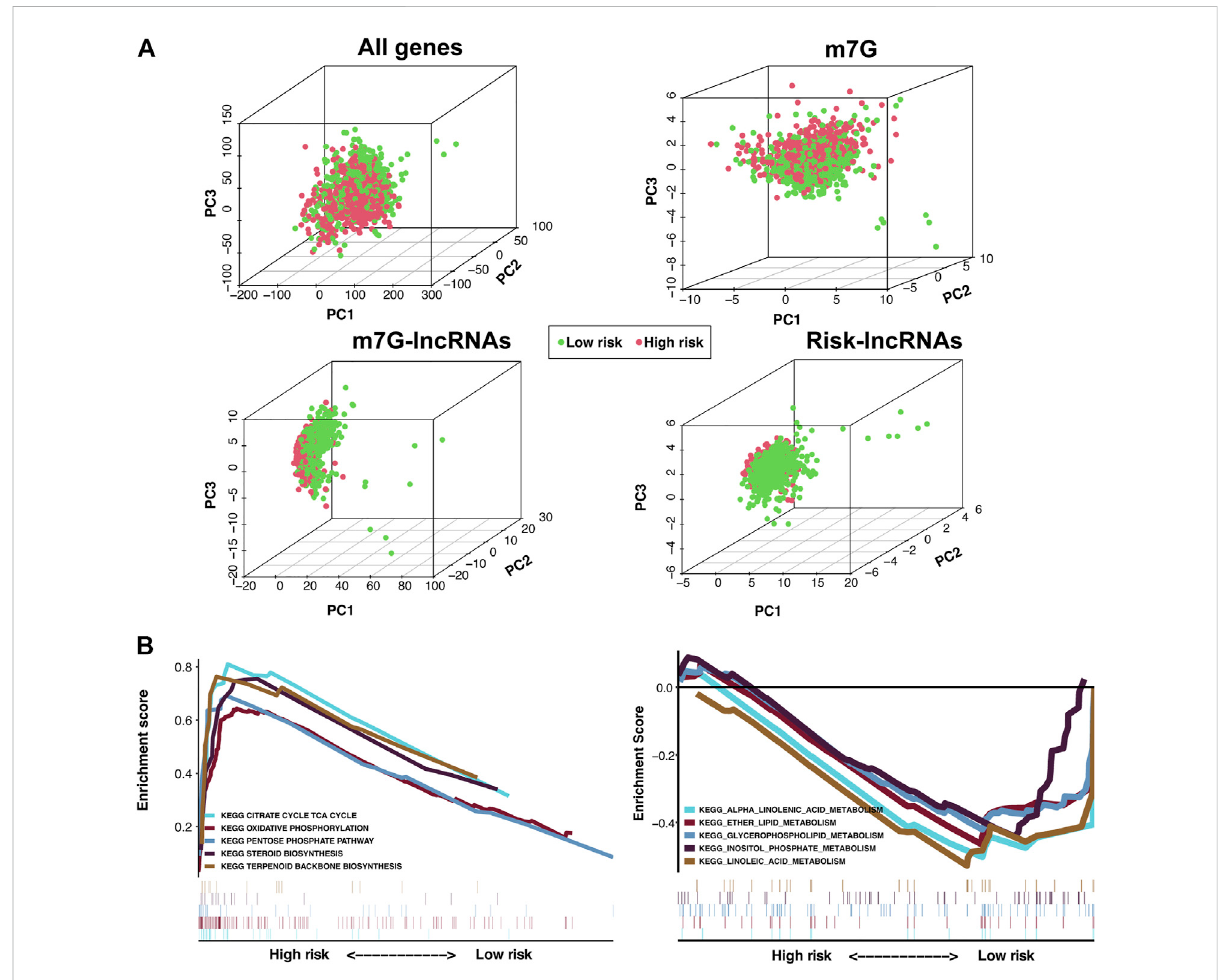
FIGURE 6 Principal component analysis (PCA) and GSEA analysis of the m7G-LPS. (A) PCA on the expression patterns of grouped samples based on the whole genome, m7G RNA modi fi cation-related genes, m7G-related lncRNAs, and the m7G-LPS expression pro fi les. (B) KEGG analysis of the m7G- LPS using